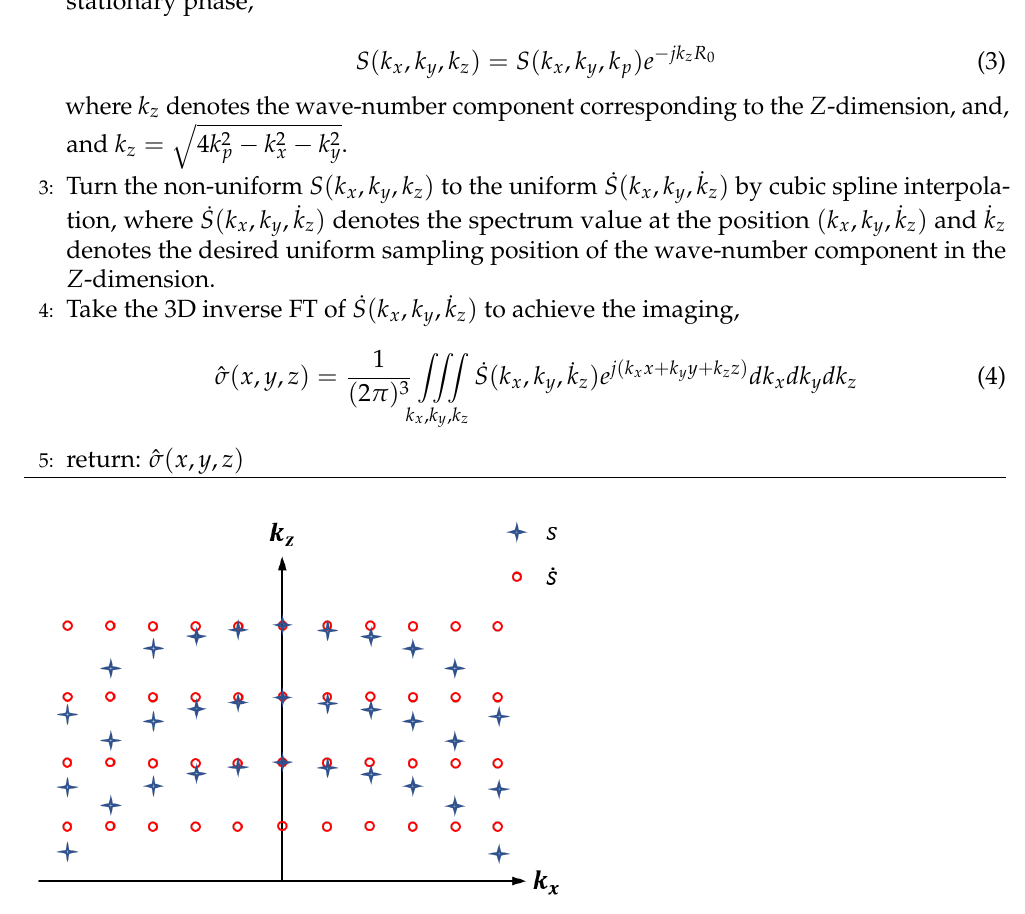
Figure 2. The wave-number domain of a certain